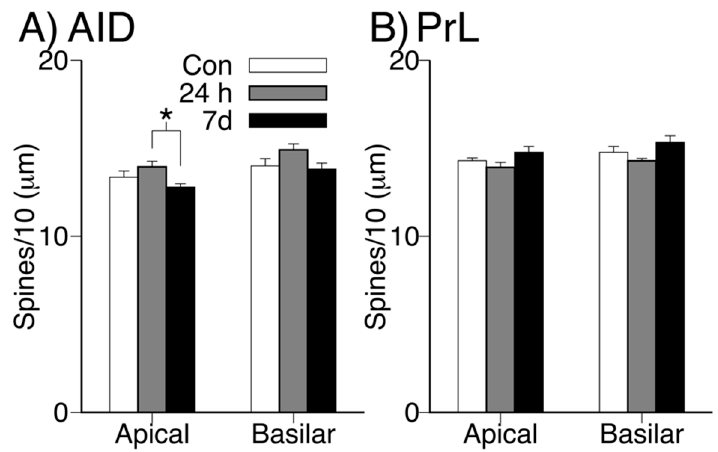
Figure 6. Mean ( + SEM) spine density in apical and basilar dendritic fields in AID ( A ) and PrL ( B ). (* p < 0.05).